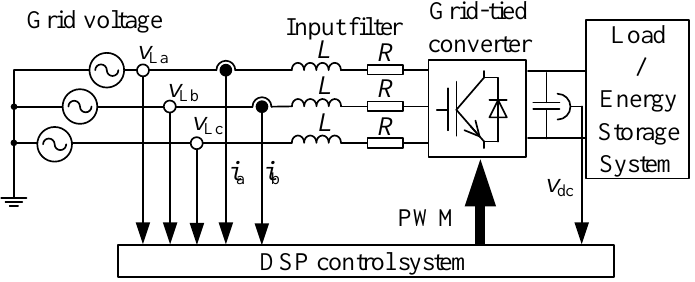
Figure 1. Scheme of the system with a three-phase three-wire grid-tied